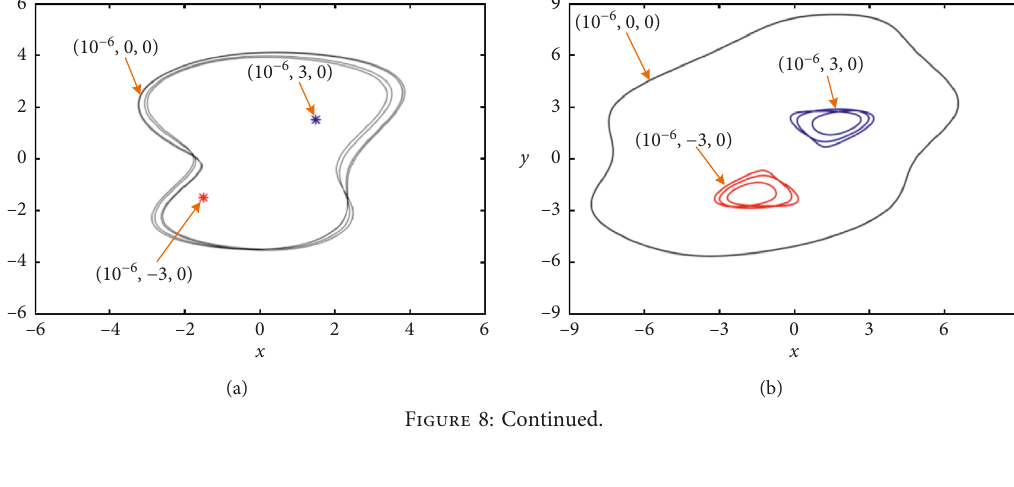
Figure 7: For three sets of initial values (10 − 6 , 0, 0), (10 − 6 , 3, 0), and (10 − 6 , –3, 0), one-dimensional bifurcation plots with the variation of the system parameter k . (a) Bifurcation diagrams of the maxima y max of the variable y . (b) First two Lyapunov exponents.